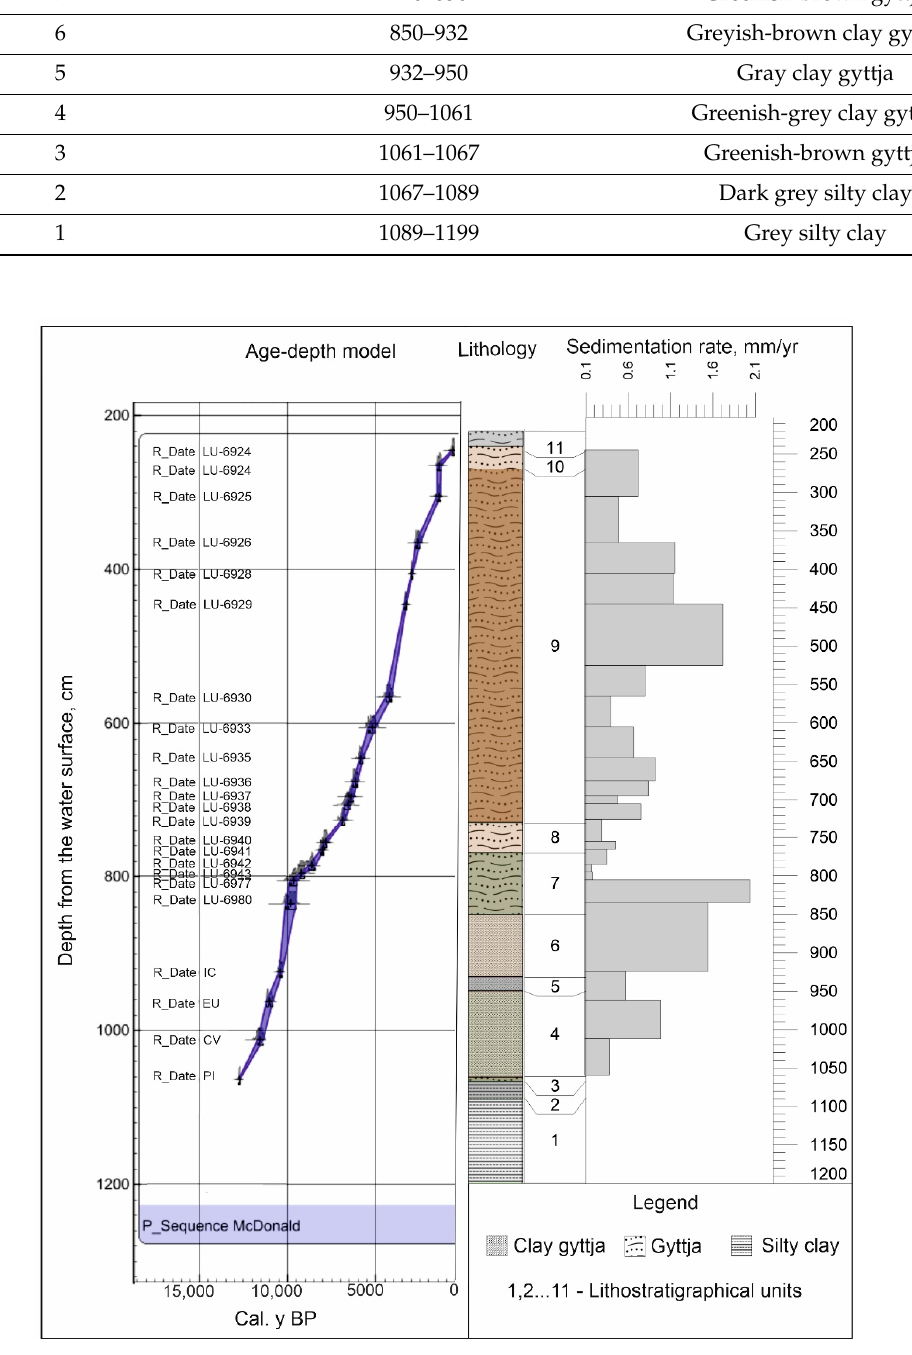
Figure 2. Age ‒ depth model for the sediment sequence of Kamyshovoye Lake. Figure 2. Age–depth model for the sediment sequence of Kamyshovoye